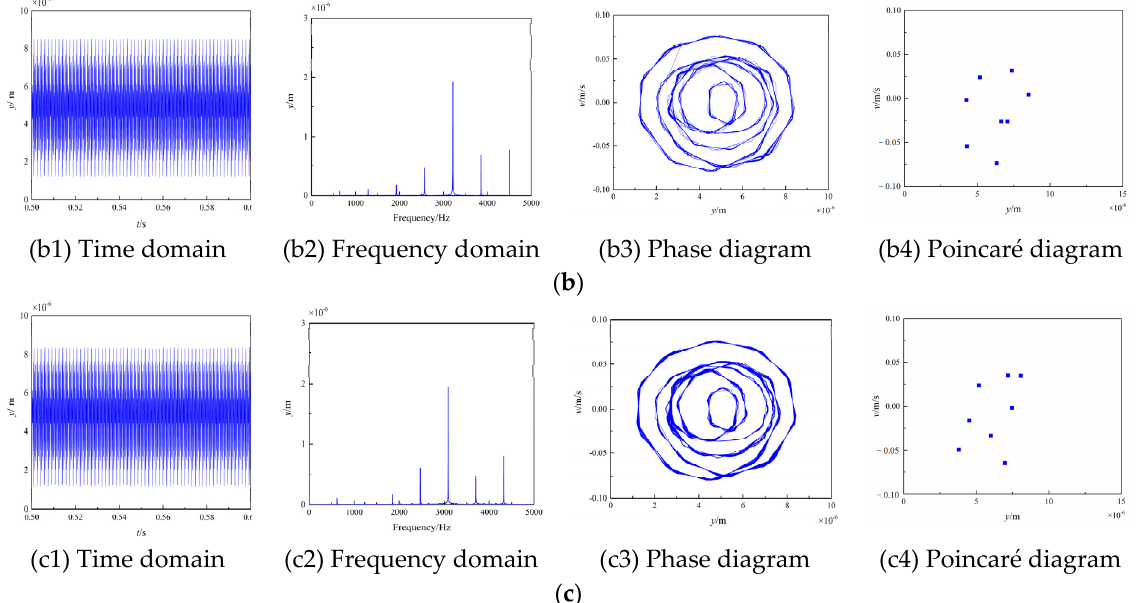
Figure 9. Time domain, frequency domain, phase diagram, poincare diagram with tooth wear. ( a ) No wear. ( b ) Mixed lubrication sliding wear. ( c ) Dry contact wear.